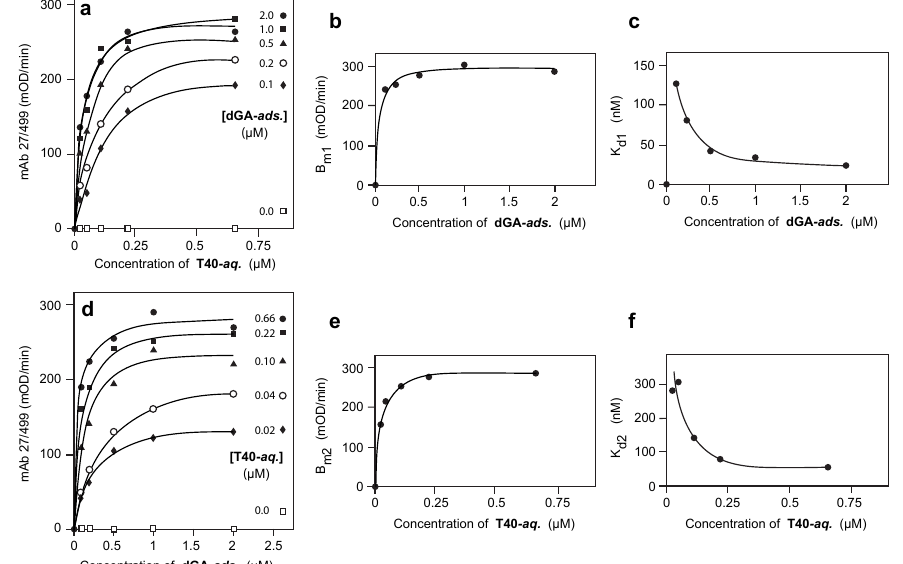
Figure 2. Tau-tau binding through the repeat domain. The truncated repeat domain dGA tau fragment was adsorbed (“ads.”) to the solid phase at the concentrations indicated and binding of full-length T40 in the aqueous-phase (“aq.”) measured immunochemically using mAb 27/499. ( a ) For any fixed concentration of dGA-ads., binding of T40-aq. could be approximated by a family of Langmuir curves (Equation (1) in text). Systematic variation in the apparent B max (B m1 , ( b )) and K d (K d1 , ( c )) values depended on the concentration of dGA-ads. and could be approximated by the empirical relationships described by Equations (2) and (3) in the text. Conversely, for any fixed concentration of T40 in the aqueous-phase, binding could be approximated by a corresponding set of Langmuir curves ( d ) (Equation (4) in text). In this case, systematic variation in the apparent B max (B m2 , ( e )) and K d (K d2 , ( f )) values depended on the concentration of T40 in the aqueous-phase and could be approximated by the empirical relationships described by Equations (5) and (6) in the text. Correlation coefficients for all approximations exceeded